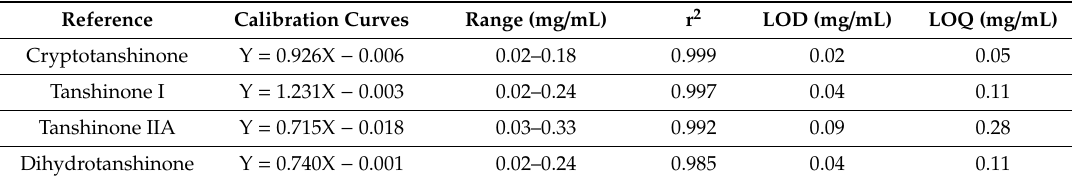
Table 1. Linearity, LOD and LOQ of four lipid-soluble ketones.